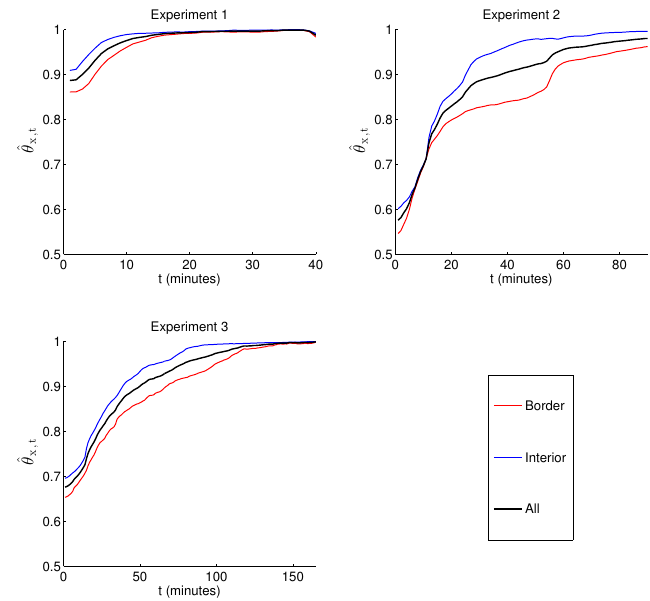
Figure 9. Soil moisture averaged for all probes, border probes, and interior probes for the three experiments. Hydrol. Earth Syst. Sci., 18, 4169–4183,